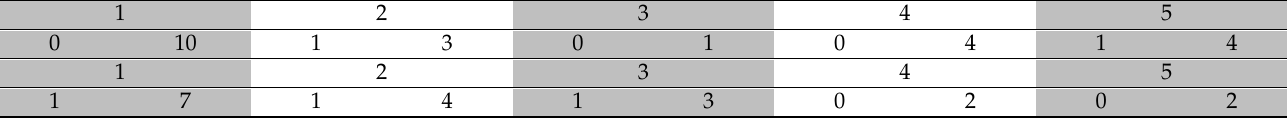
Table 6. Chromosome of successive